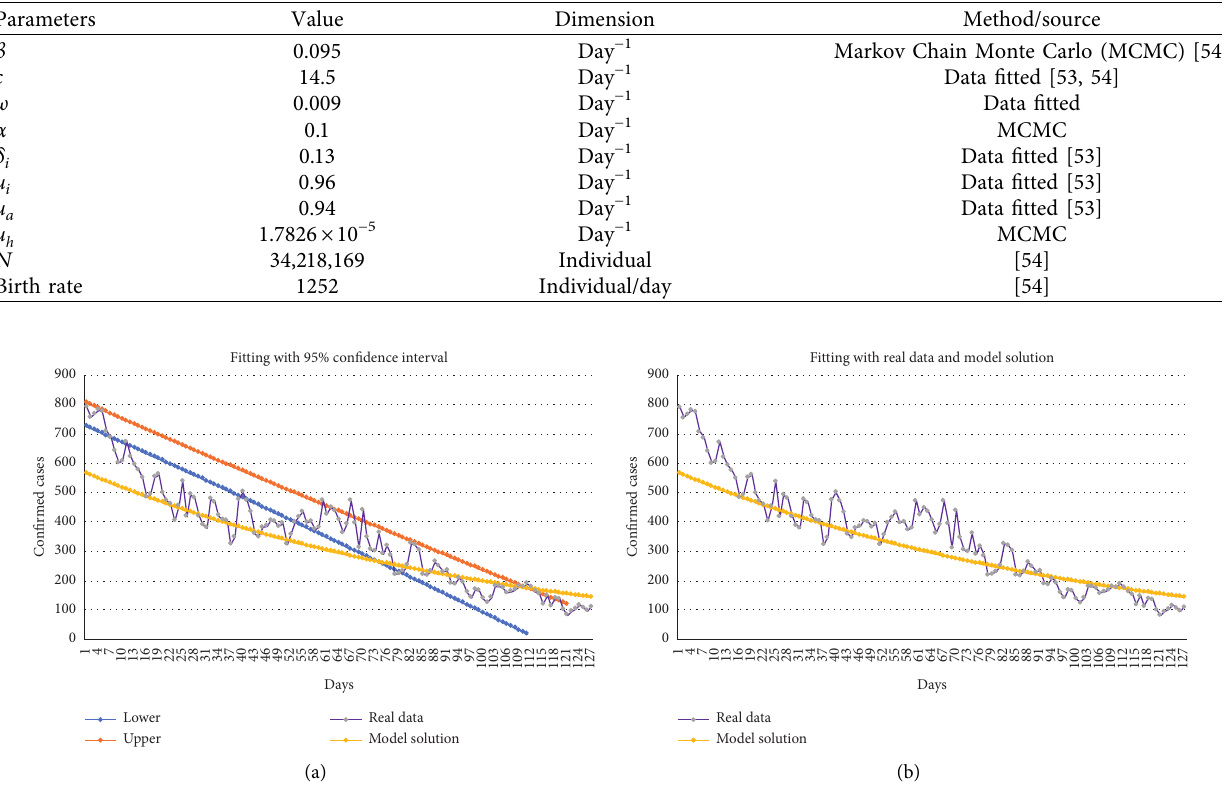
Figure 7: (a) Fitting between the solution of the model and the real data with 95% confidence interval. (b) Fitting between the solution of the model and the real